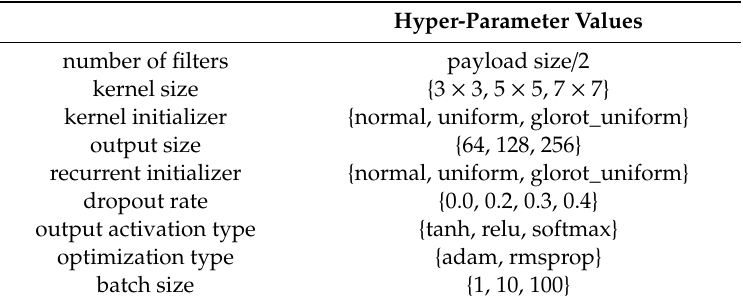
Table 2. The grid search hyper-parameter sets for the CNN + LSTM model.